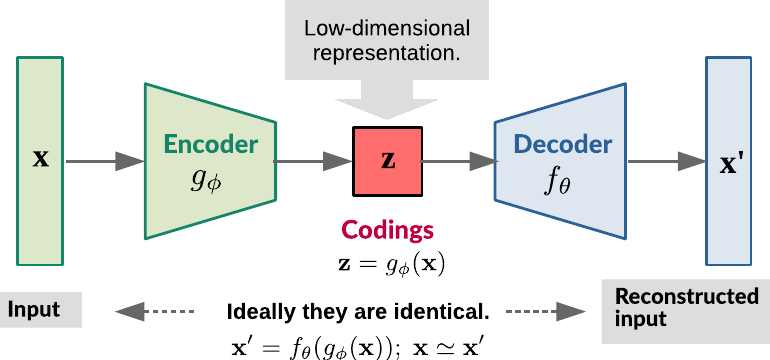
Figure 5. A simplified illustration of the autoencoder model.